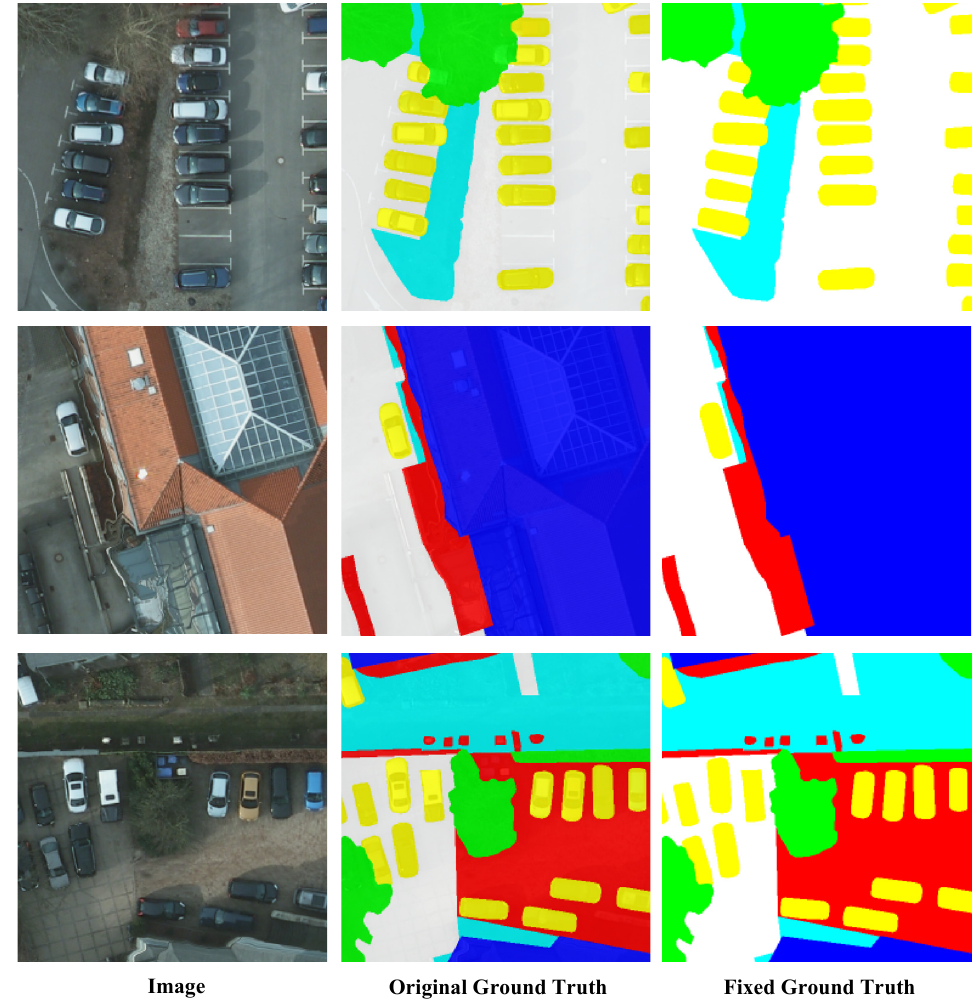
Figure A1. Error and binarization-corrected labels in the Potsdam datasets (best viewed when colored and zoomed in).